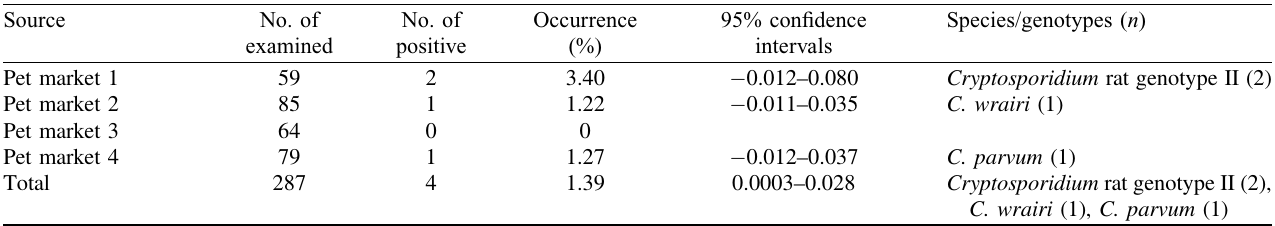
Table 1. Occurrence and species/genotypes of Cryptosporidium in pet red-bellied tree squirrels from different sources in Southwestern China.